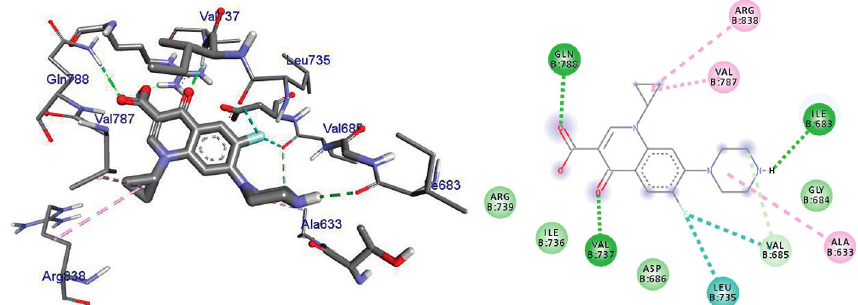
Figure 4: Percent radical scavenging activity of synthetic